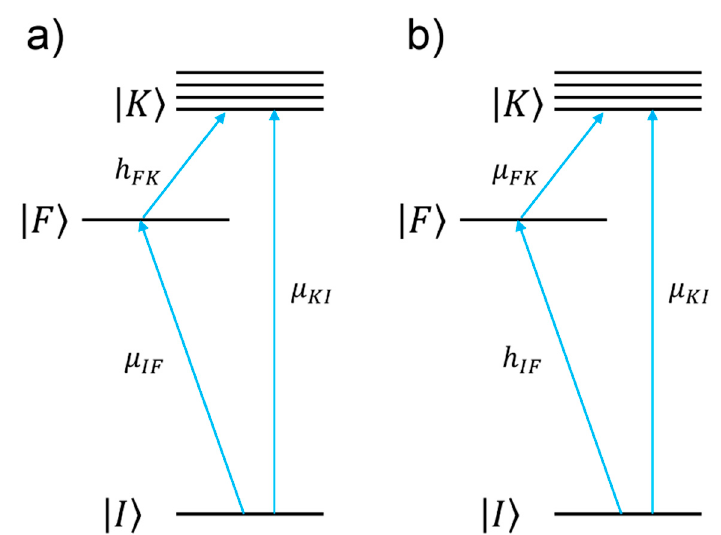
Figure 3. The molecule to metal and the metal to molecule charge transfer are illustrated in panels ( a , b ), respectively. |𝐼⟩ , |𝐾⟩ , and |𝐹⟩ represent the molecular ground state, the molecular excited state(s), and the Fermi state of the metal, respectively. 𝜇 (cid:3012)(cid:3010) , 𝜇 (cid:3010)(cid:3007) , and 𝜇 (cid:3007)(cid:3012) are the transition dipole moments. ℎ (cid:3007)(cid:3012) and ℎ (cid:3010)(cid:3007) are the Herzberg–Teller coupling parameters. Reprinted (adapted) with permission from Lombardi et al. [9]. Copyright (2008) American Chemical